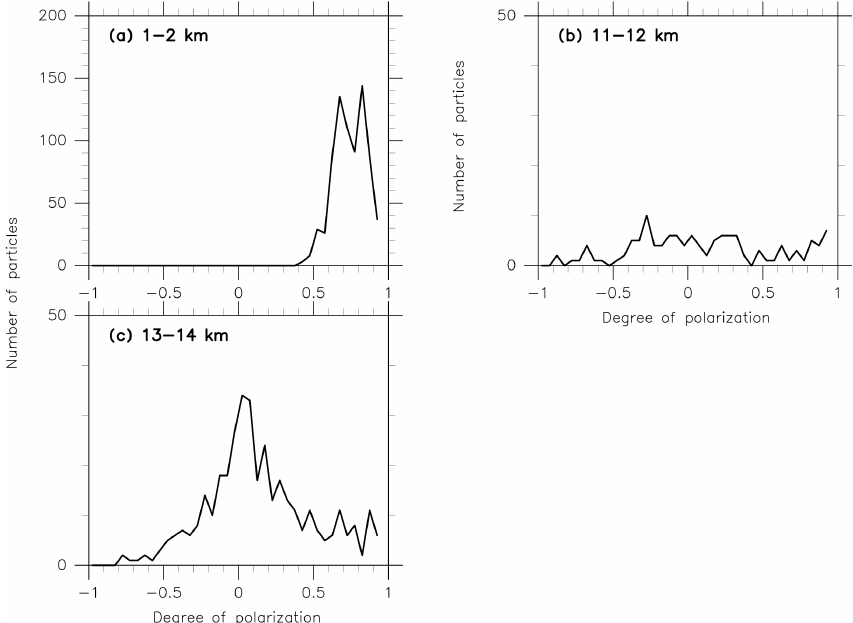
Figure 10. As for Fig. 7, but from the results shown in Fig. 9 at (a) 1–2km (water clouds), (b) 11–12km (ice clouds), and (c) 13–14km (ice clouds).